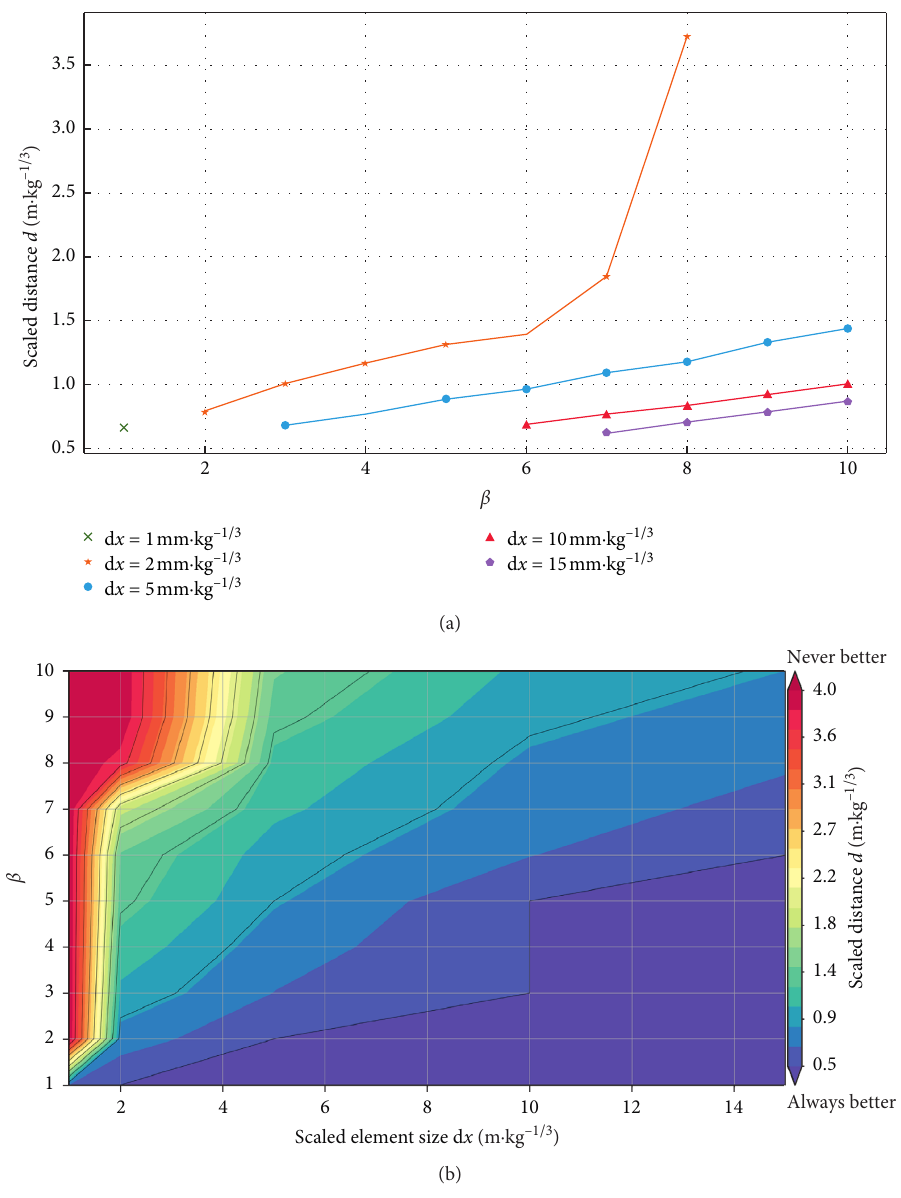
Figure 14: Scaled distance d as function of the beta parameter and the reduced mesh size d x